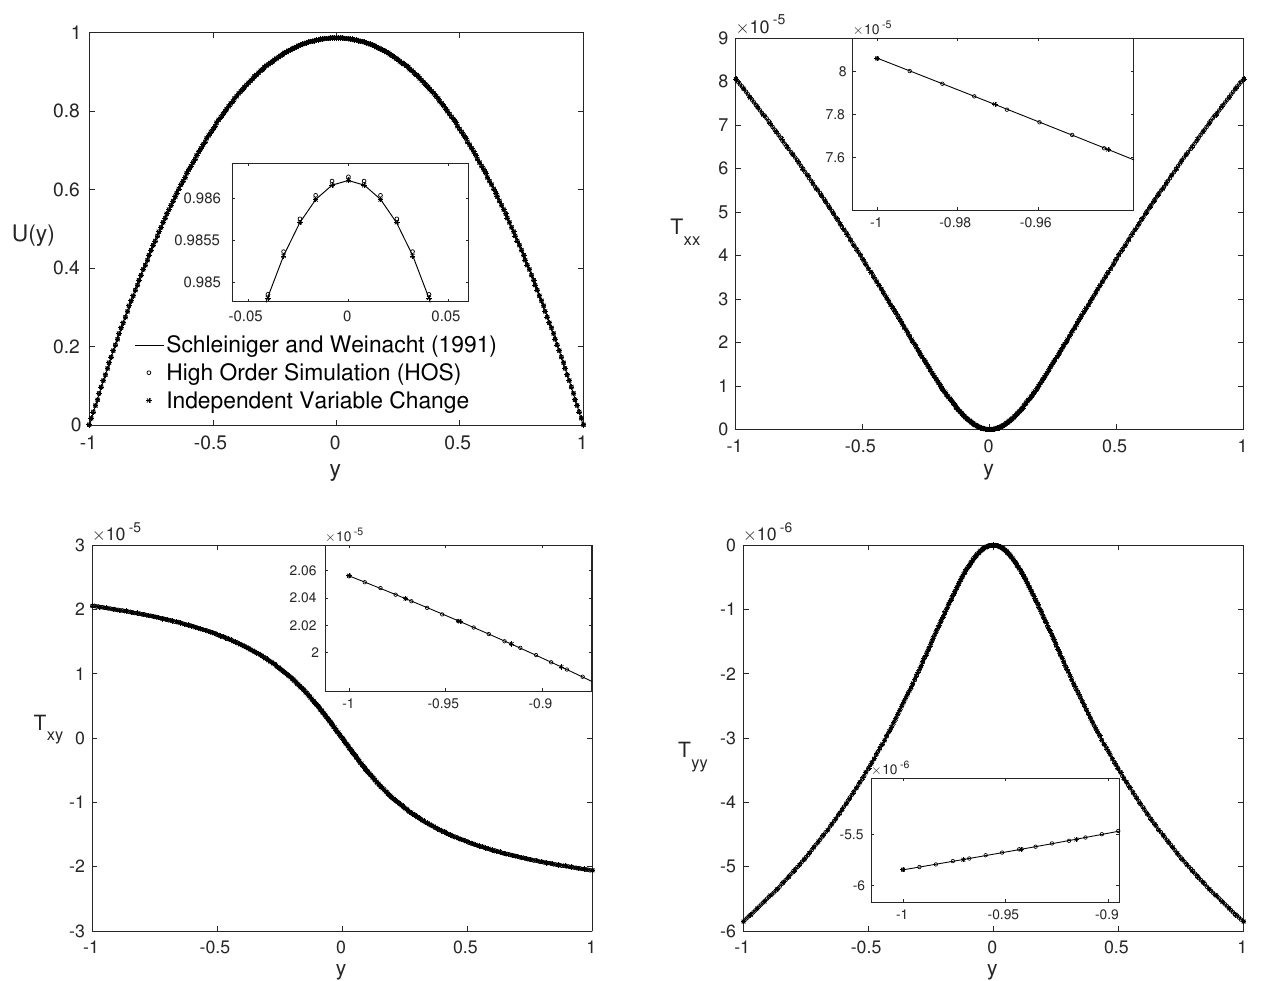
Figure 3. Same as in Figure 1 for dimensionless numbers: Re = 8000, β = 0.75, α G = 0.2 and Wi =